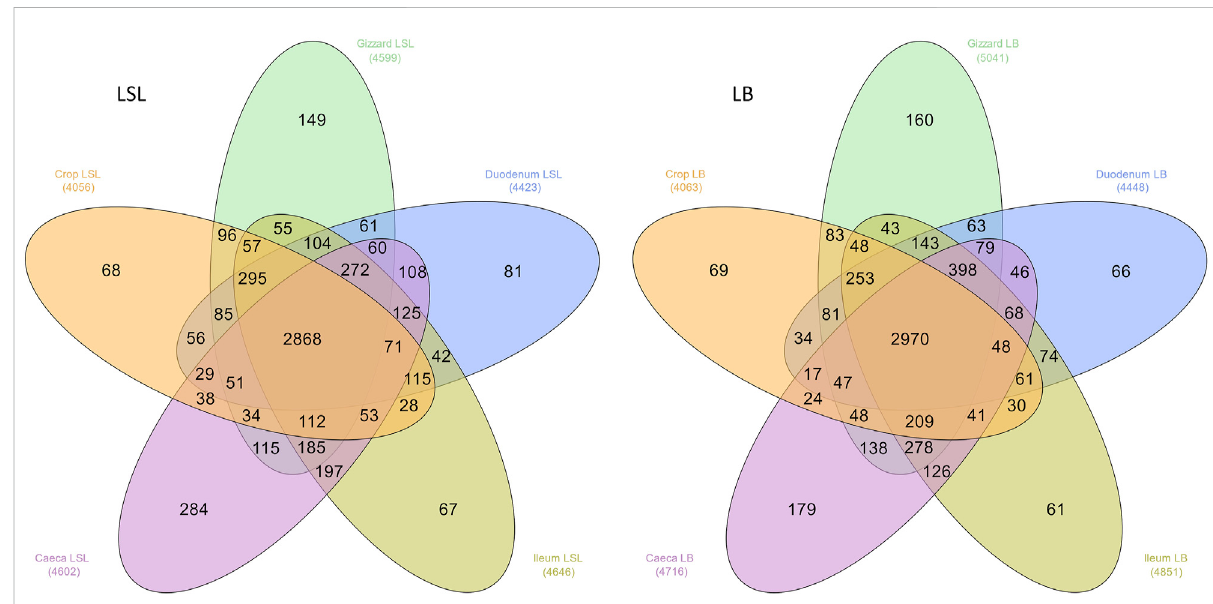
FIGURE 1 Distribution of the total number of ASVs among GIT sections across all samples in both breeds. The number in parenthesis is the observed number of ASVs in each group.